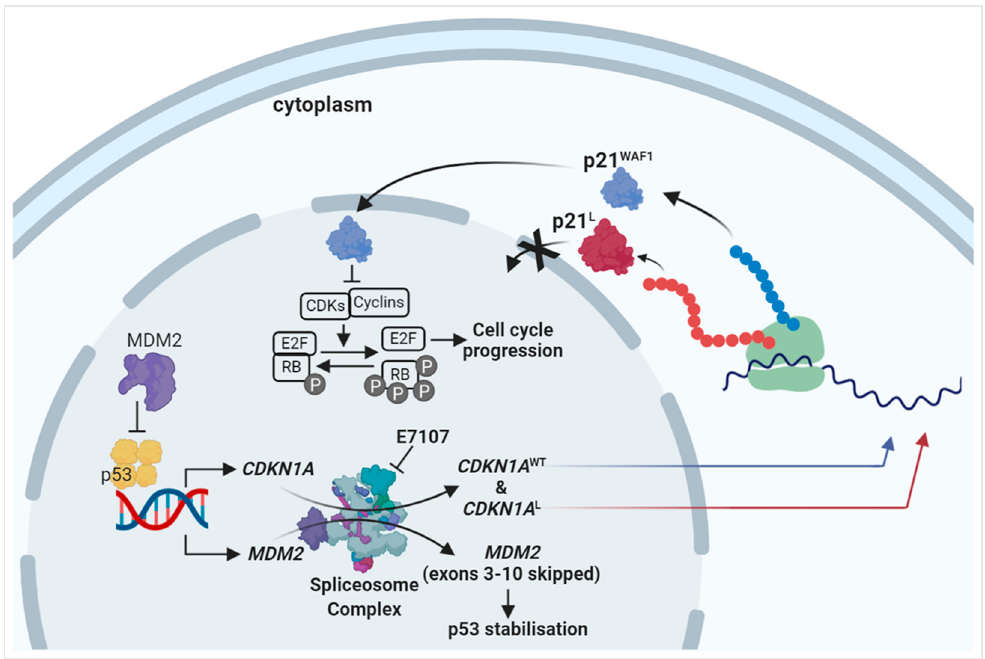
Figure 7. Proposed mechanism for the effect of spliceosome inhibition by E7107 on the p53 path- way and synergy with MDM2 inhibitors. E7107 forces the spliceosome complex to malfunction and produce aberrant products. Reduced full-length MDM2 production due to exon skipping results in enhanced stabilization and the activation of p53. Nuclear p53 induces more CDKN1A transcription, but some of these transcripts are subject to aberrant splicing, in this case in the form of intron re- tention generating a long form of p21 (p21 L ). Wild-type p21 WAF1 localises to the nucleus to function as a cyclin-dependent kinase inhibitor to arrest the cell cycle. Altered p21 (p21 L ) protein with an alternative C-terminus, however, loses its ability to act as a cyclin-dependent kinase inhibitor due to the loss of the ability to localise to the nucleus. This loss of the protective effect of normal p21 against apoptosis contributes to the sensitization of the cells to the enhanced p53 stabilisation and p53-dependent proapoptotic signals resulting from the combined effect of MDM2–p53 binding antagonists and MDM2 exon skipping due to E7107 treatment.